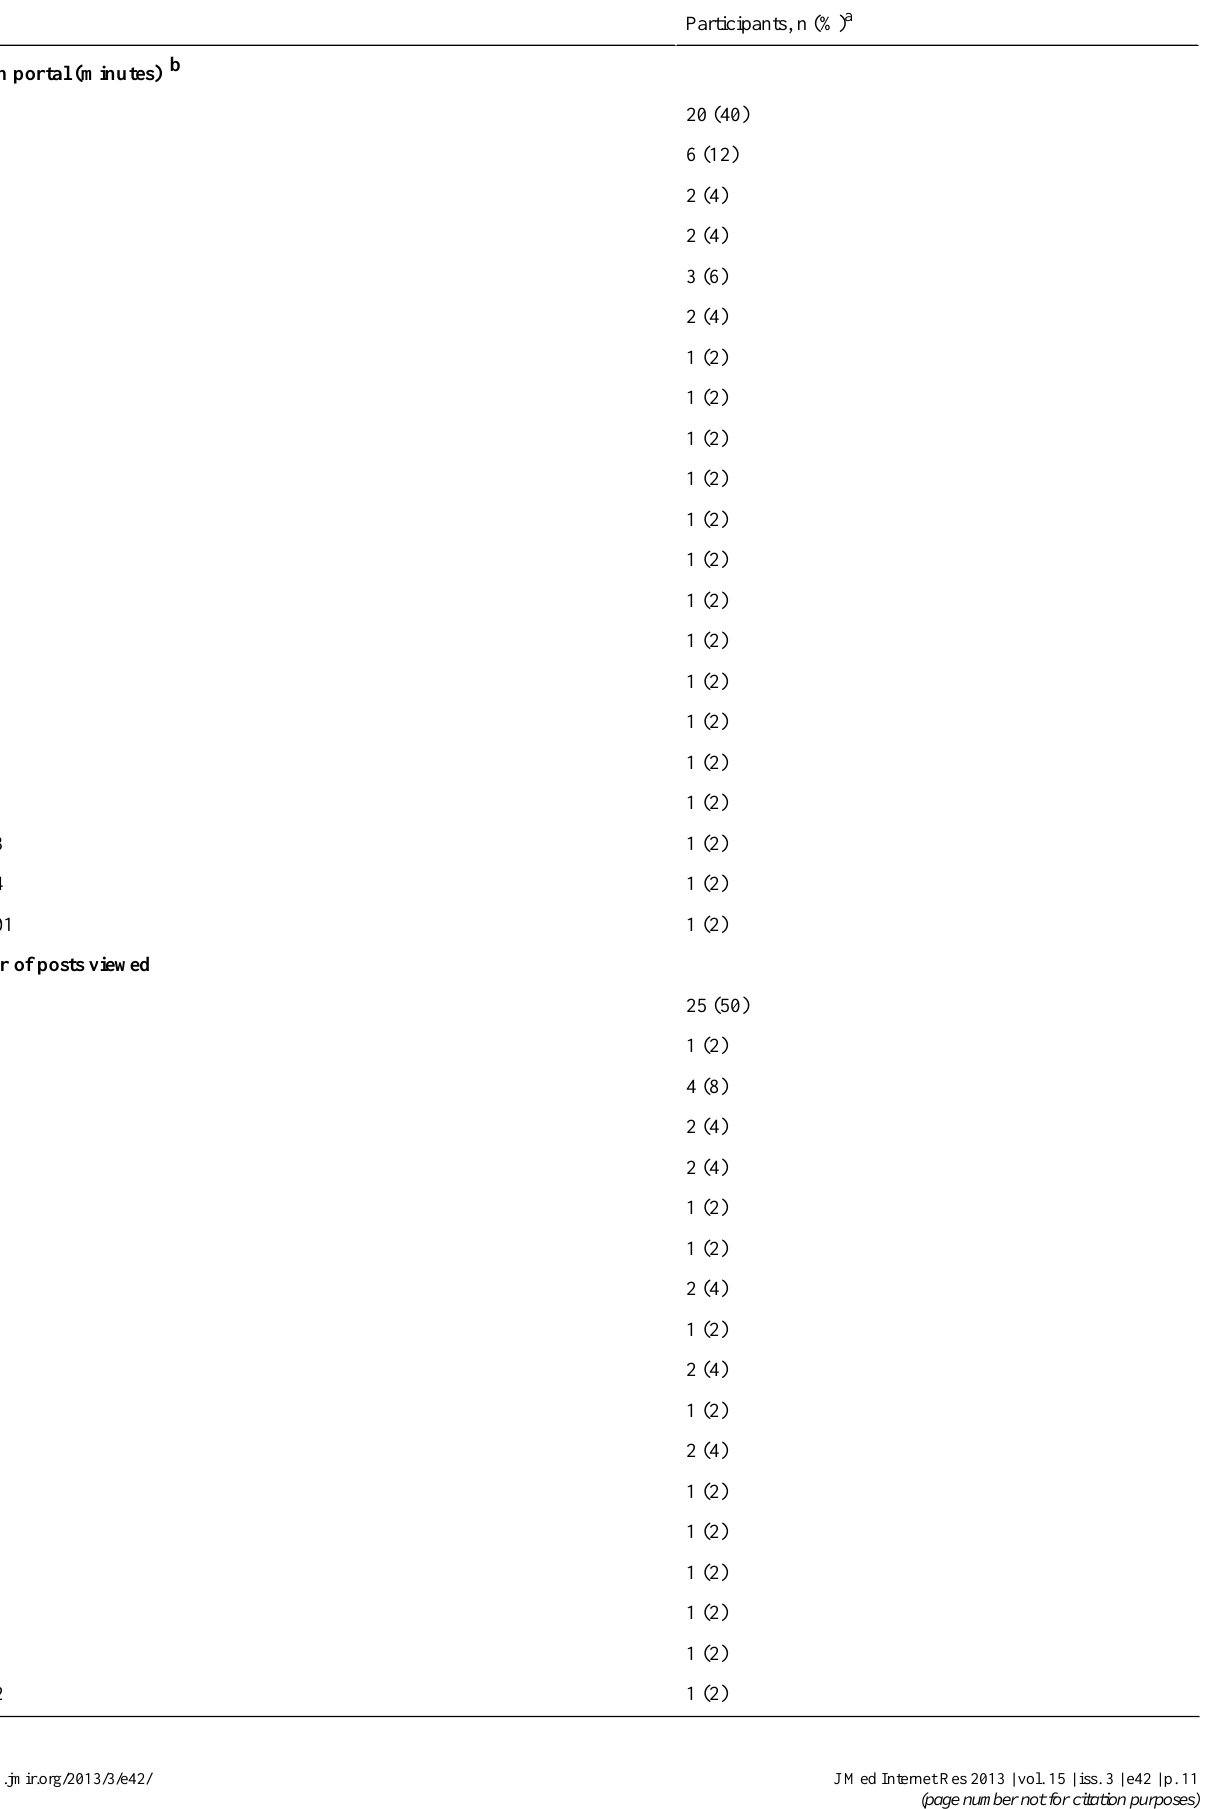
Table 3. Time on portal, posts viewed, and number of communications for entire